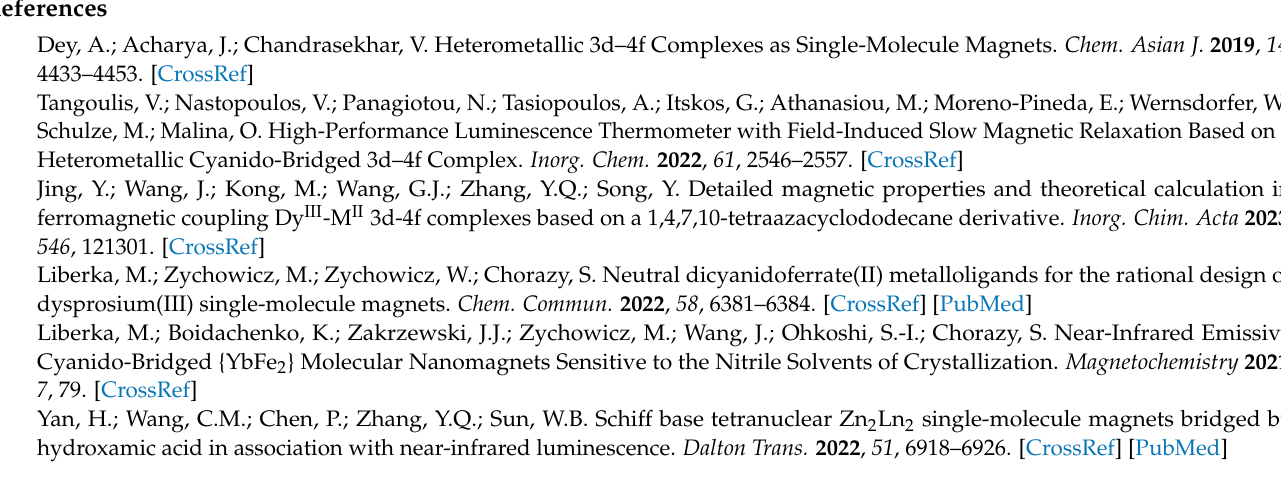
Figure S4: Portion of the crystal packing of 2-Eu; Figure S5: Powder-XRD patterns; Figure S6: Schematic representation of the CN ··· H angle in [Fe(Phen) 2 (CN) 2 ] · 2H 2 O · CH 3 CN; Figure S7: Electronic absorp- tion of CH 3 CN solutions and solid-state diffuse reflectance spectra of 1-Er and 2-Er compared with the precursor [Fe(Phen) 2 (CN) 2 ] complex; Figure S8: Solid-state diffuse reflectance spectra of crys- talline samples of 1-Ln (Ln = Er, Gd, Eu); Table S1: Summary of X-ray crystallographic data for Table S3: Selected bond lengths (Å) and angles ( ◦ ) for 2-Ln; Table S4: DFT-calculated molecular or- bitals of [Fe(phen) 2 CN 2 ]; Table S5: DFT-calculated molecular orbitals of 1-Er; Table S6: DFT-calculated molecular orbitals of